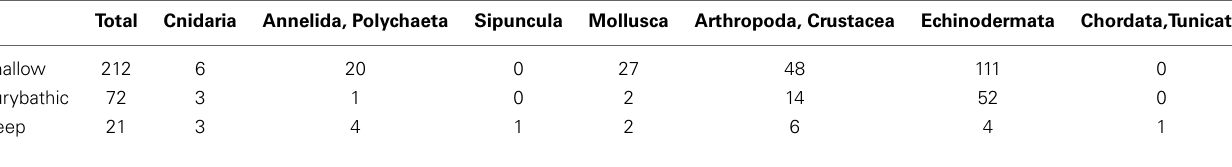
Table 1 | Number of species for which PLD has been